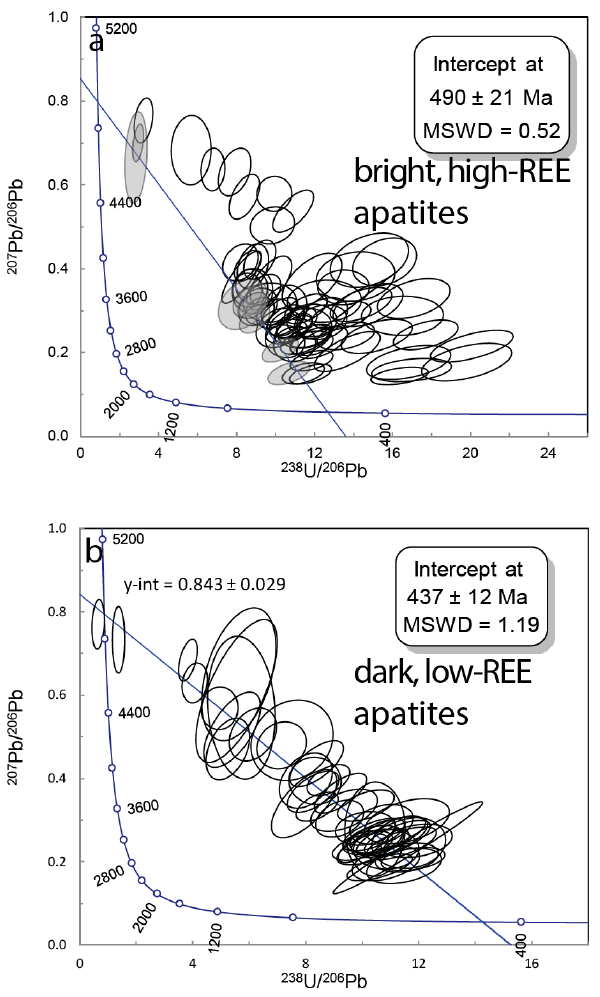
Figure 15. ( a , b ) Concordia diagrams for the bright, high-REE and the dark, low-REE apatites from Chadormalu (data from Tables 8 and 9).